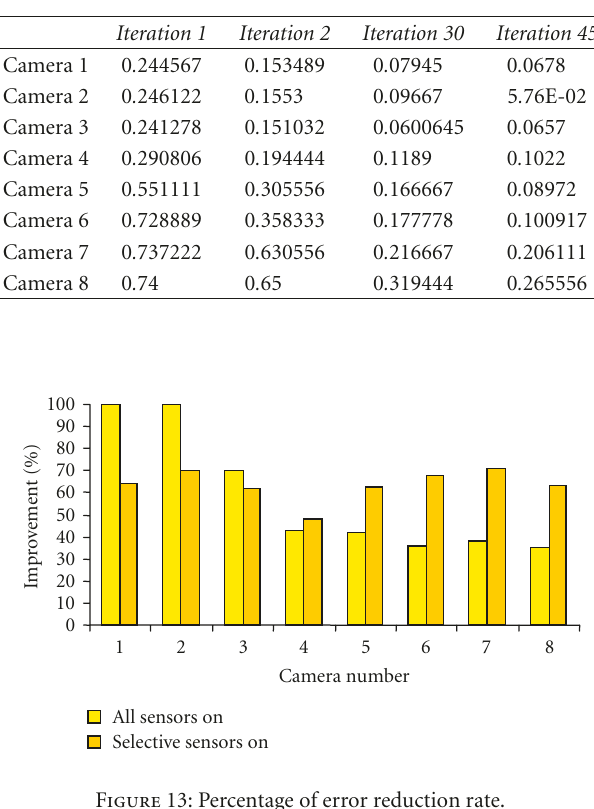
Table 8: Mis Err t i rates during incremental learning initial train- ing set = 136000. Weak and strong sensor combination used.